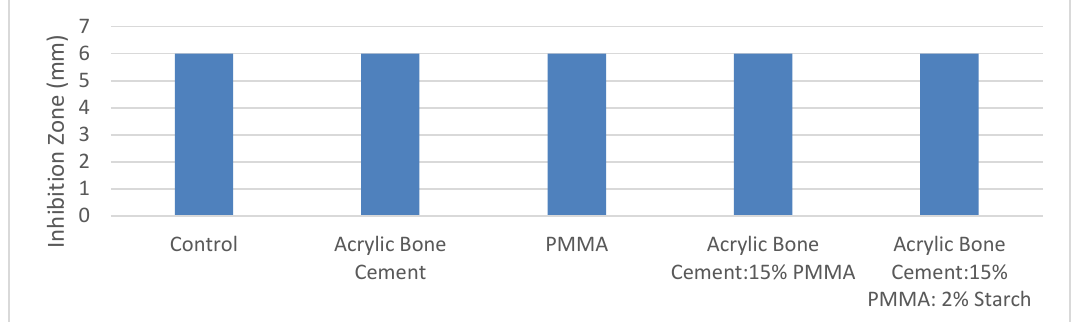
Figure, 3: Biological activity of acrylic bone cement, PMMA, (Acrylic bone cement: 15% PMMA), and (Acrylic bone cement: 15 % PMMA: 2% starch) against gram negative bacteria Escherichia coli ( E. coli ). All samples were kept during incubation periods at 37 ºC for 24